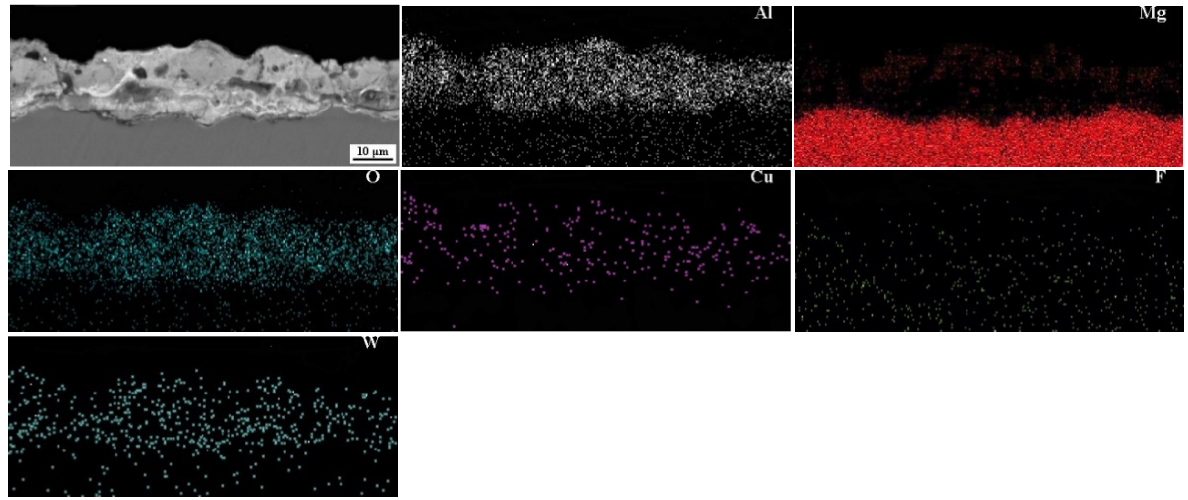
Figure 6. SEM cross-sectional micrographs and corresponding elemental distribution of sample 5 # .